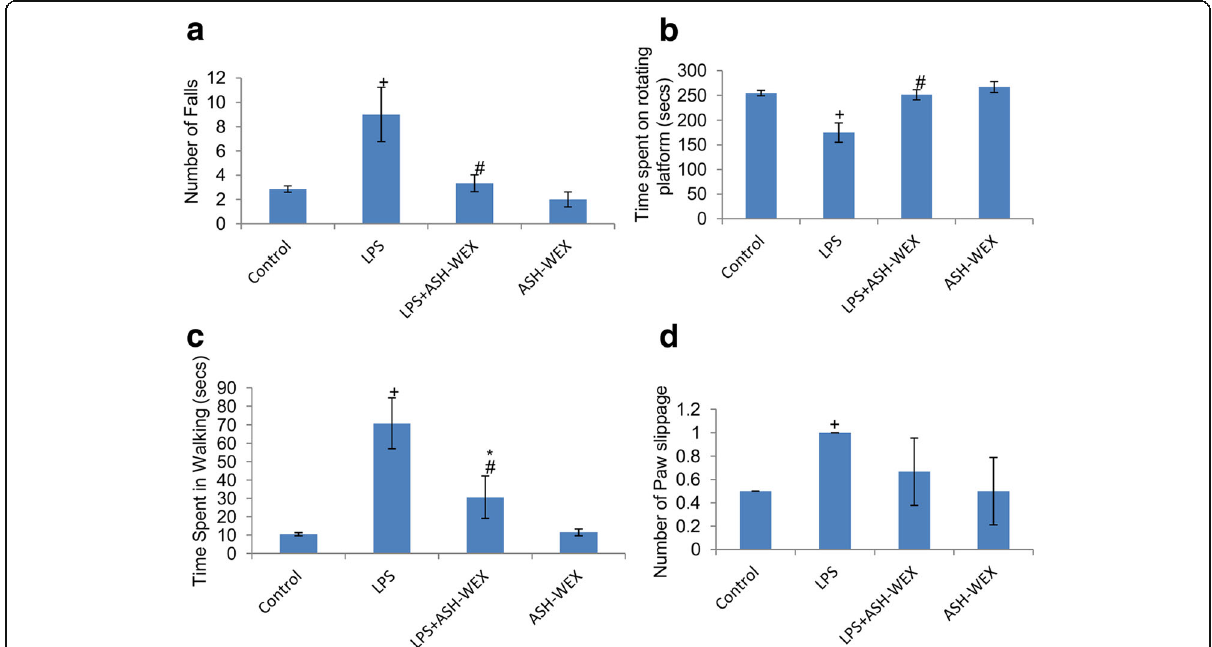
Fig. 1 ASH-WEX improves the locomotor coordination impaired due to LPS-induced sickness behavior During rotarod test ( n = 8/group), ASH- WEX supplemented LPS (LPS + ASH-WEX)-treated rats exhibited better performance than LPS-treated animals as evaluated by their ( a ) latency to fall and ( b ) time spent on rotating rod. ASH-WEX administration also improved the performance of LPS + ASH-WEX rats in narrow beam walking test which was adversely affected by LPS as assessed by ( c ) time taken and ( d ) paw slippage to cross the beam thus implying their intact motor functions. Values are expressed as mean ± SEM. * p ≤ 0.05 control versus ASH-WEX alone and LPS + ASH-WEX groups. + p ≤ 0.05 control versus LPS alone group. # p ≤ 0.05 LPS alone versus LPS + ASH-WEX group (one-way ANOVA with Holm-Sidak post hoc